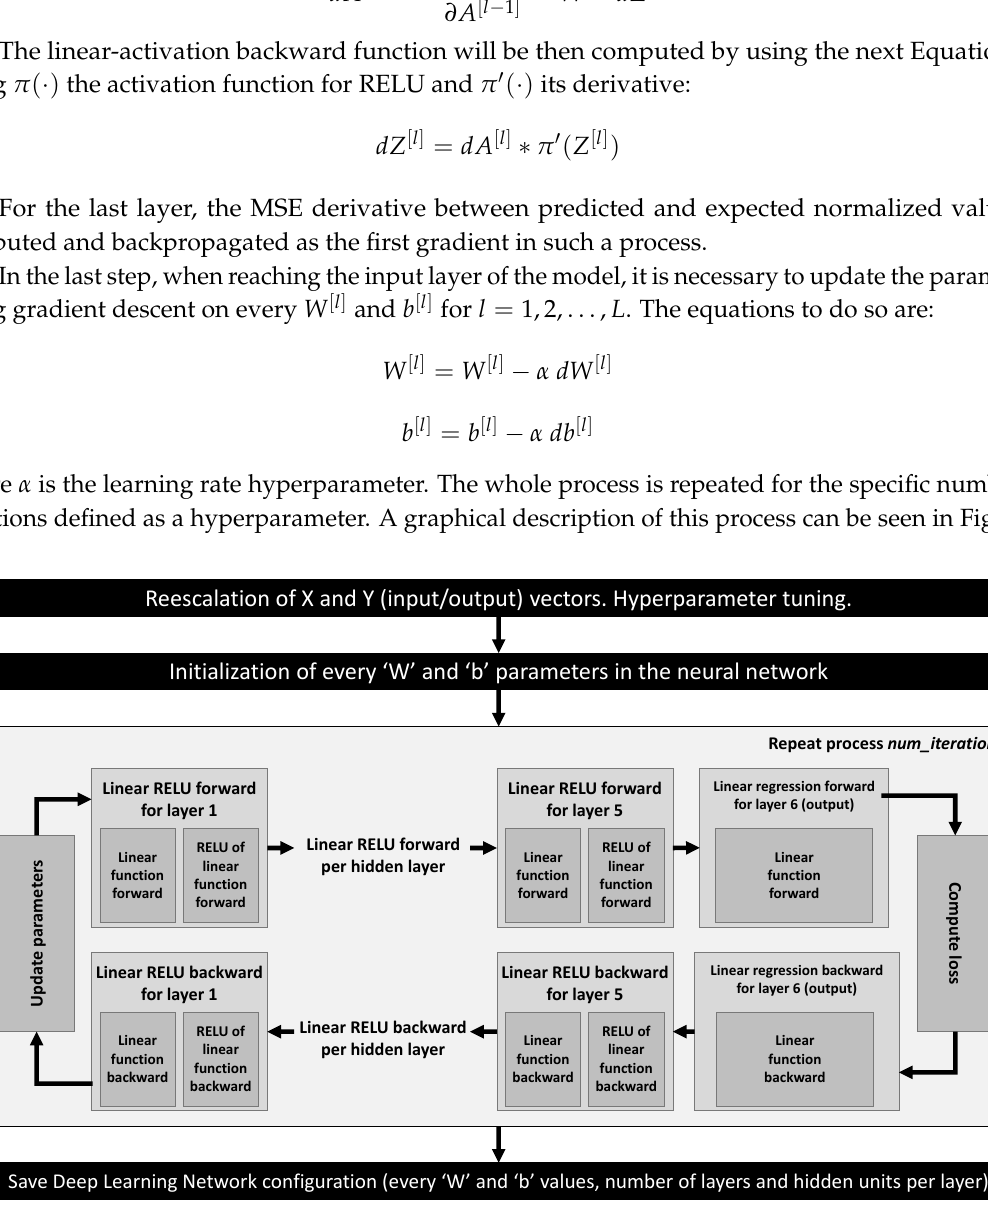
Figure 4. DNN configuration and training procedure